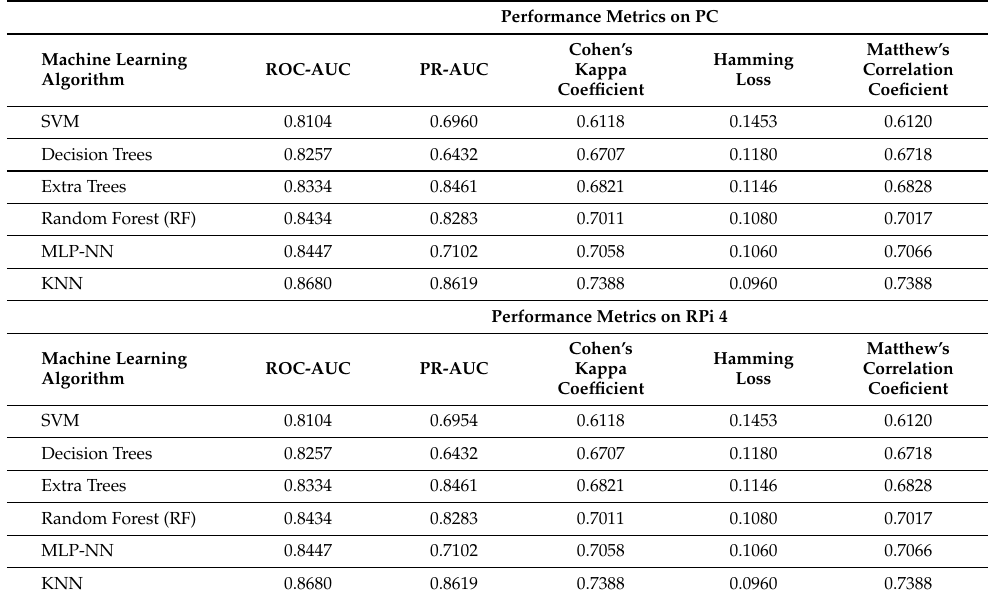
Table 9. Performance metrics of the six ML algorithms evaluated in this study using 15% of the separated data for